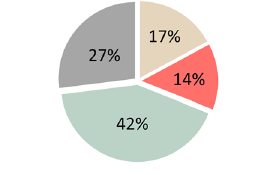
Fig. 7 Percentage of each dialect in the arHateDataset